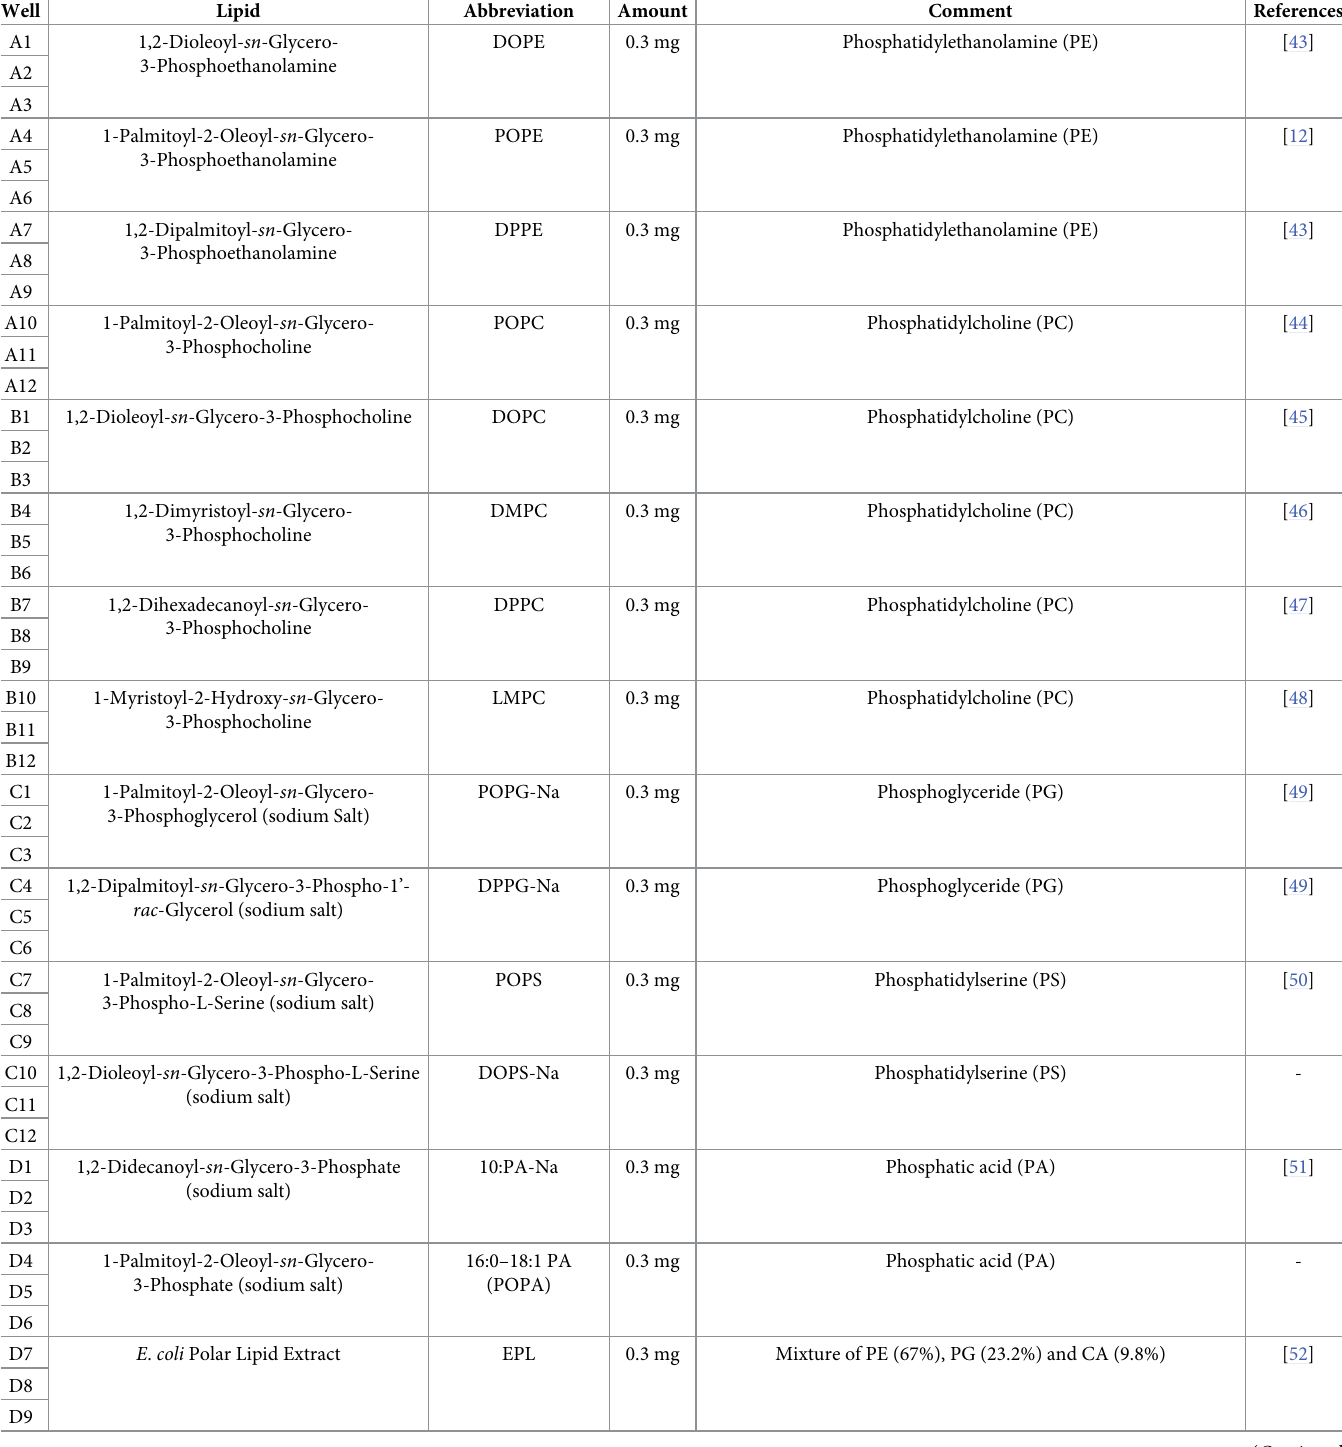
Table 1. Lipid screen design containing 31 different lipids or lipid